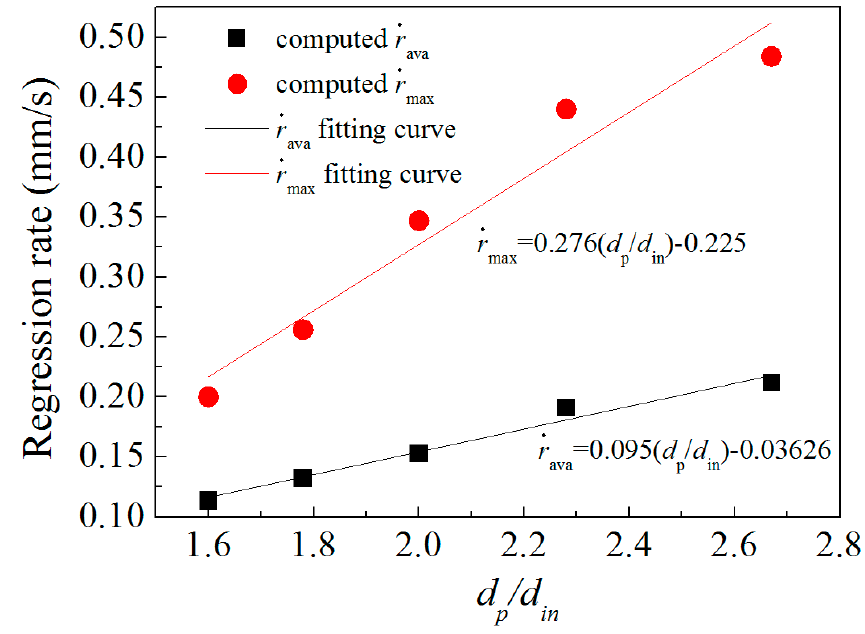
Figure 32. Regression rate for different sudden expansion ratio with d p fixed as constant.